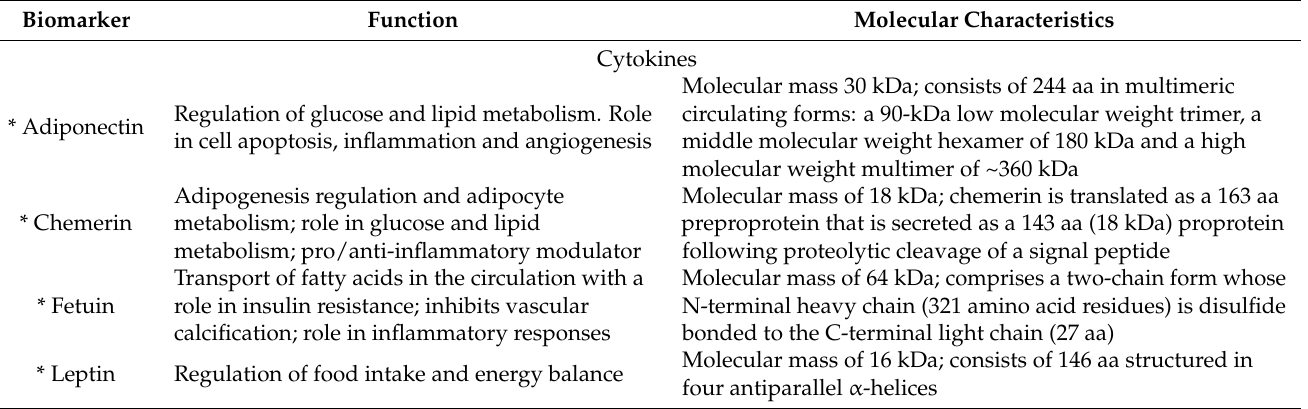
Table 1. Protein biomarkers ( n = 15) identified post-application of post hoc criteria.